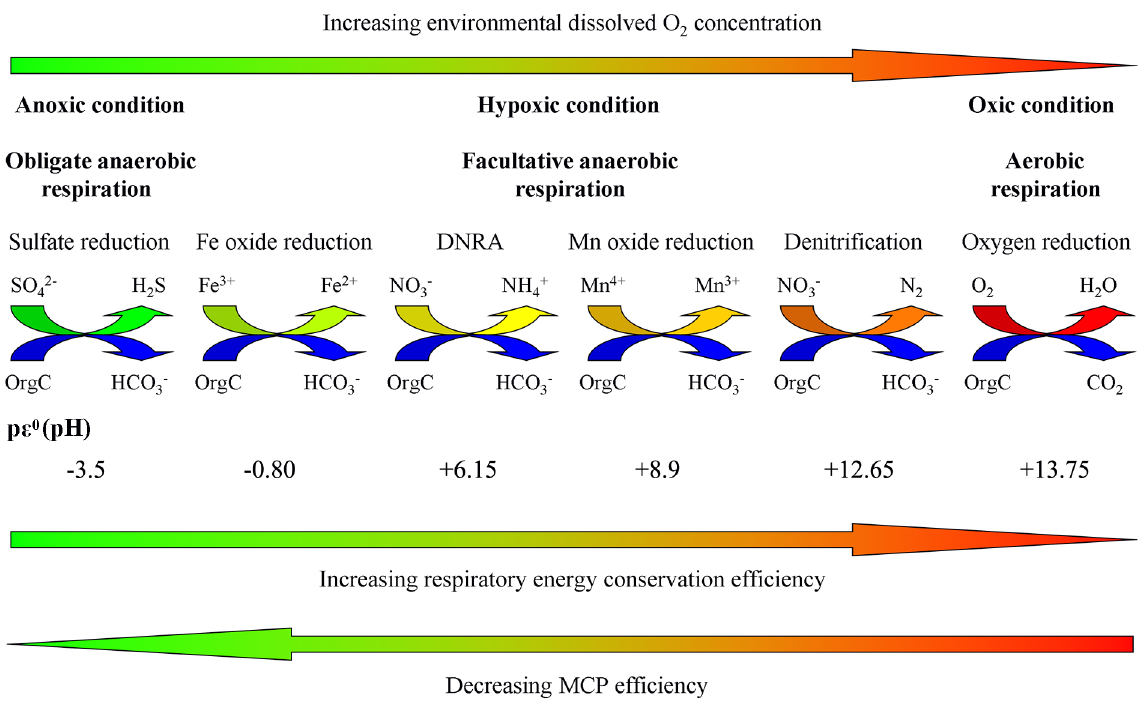
Figure 2. Schematic of microbial aerobic and anaerobic respiration pathways and their potentially different contribution to cellular metabolic energy transduction and MCP efficiencies. pε 0 (pH) values refer to the electron activity for unit activities of oxidants and reductants at neutral pH (Nealson and Saffarini,